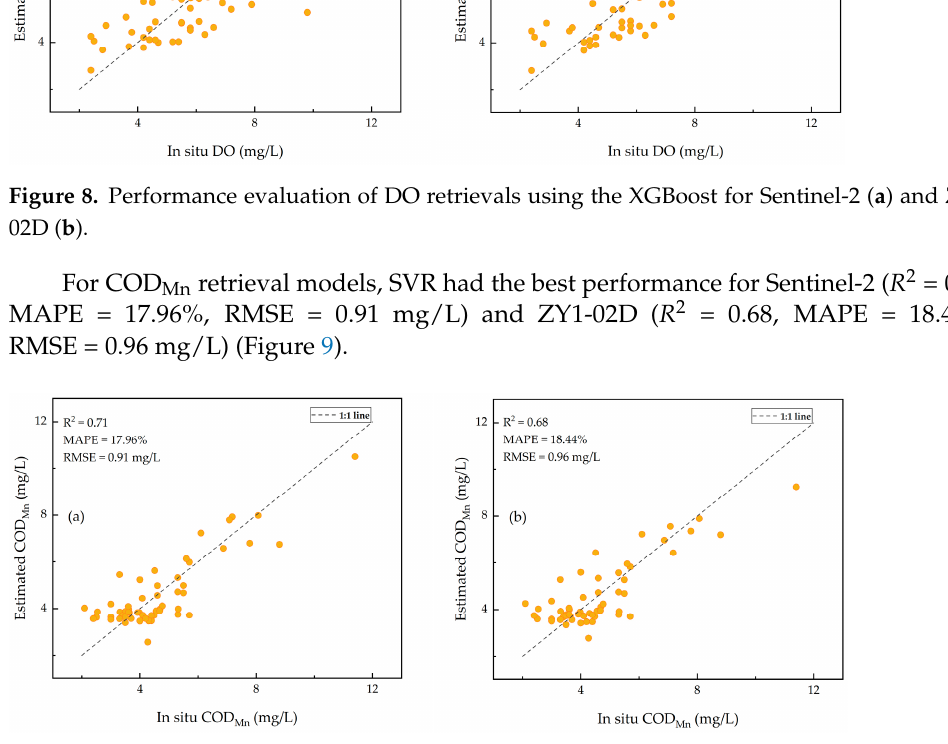
Figure 9. Performance evaluation of COD Mn retrievals using the SVR for Sentinel-2 ( a ) and ZY1-02D ( b ). For TP retrieval models, SVR had the best performance for Sentinel-2 (R 2 = 0.46, MAPE = 37.81%, RMSE = 0.08 mg/L) and XGBoost had the best performance for ZY1-02D (R 2 = 0.47, MAPE = 37.04%, RMSE = 0.07 mg/L) (Figure 10).